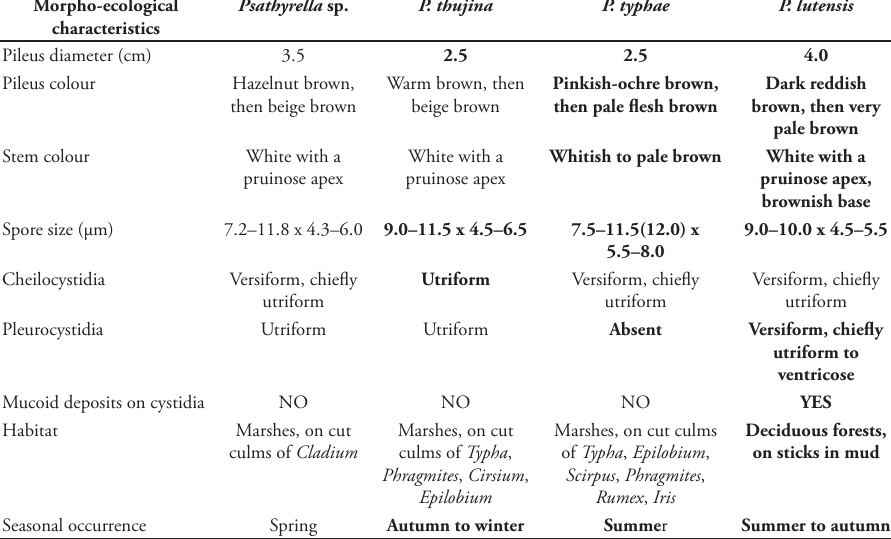
Table 1. Main differences between our Psathyrella sp. and the closest species, according to the morpho- logical characteristics of basidiomes and mycelium, and ecology. (Differences from our specimen are in bold